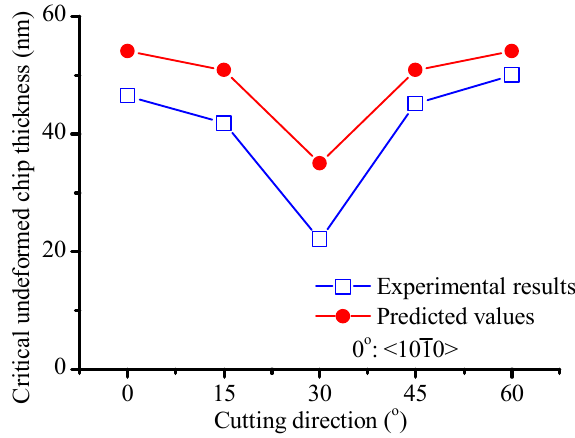
Figure 13. Predicted and experimental values of (cid:1872) (cid:3030)(cid:3045)(cid:3036)(cid:3047)(cid:3036)(cid:3030)(cid:3028)(cid:3039) .